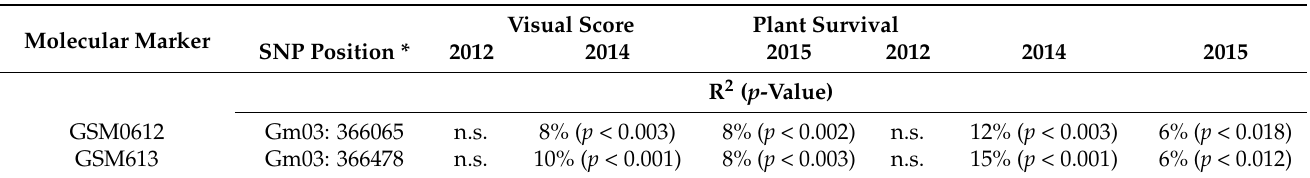
Table 4. Alleles significantly associated with visual scores and plant survival rate in the years 2014 and